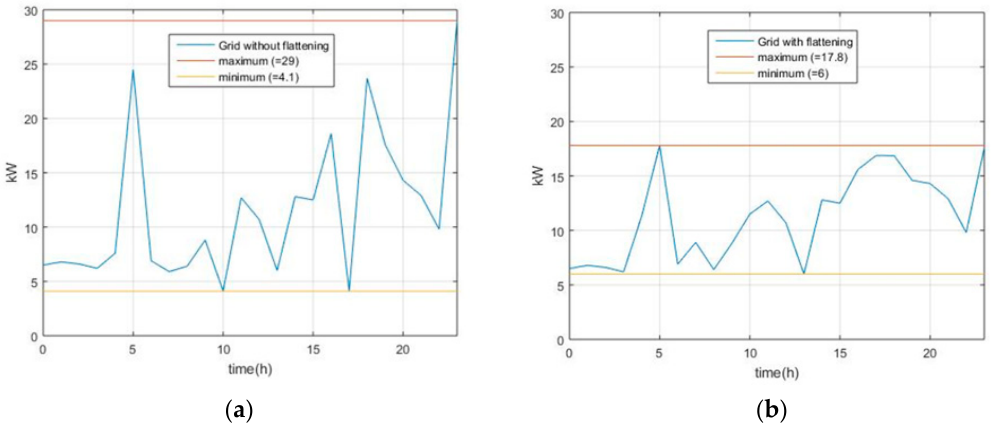
Figure 11. Grid power ( a ) flattening was unapplied ( b ) flattening was applied.